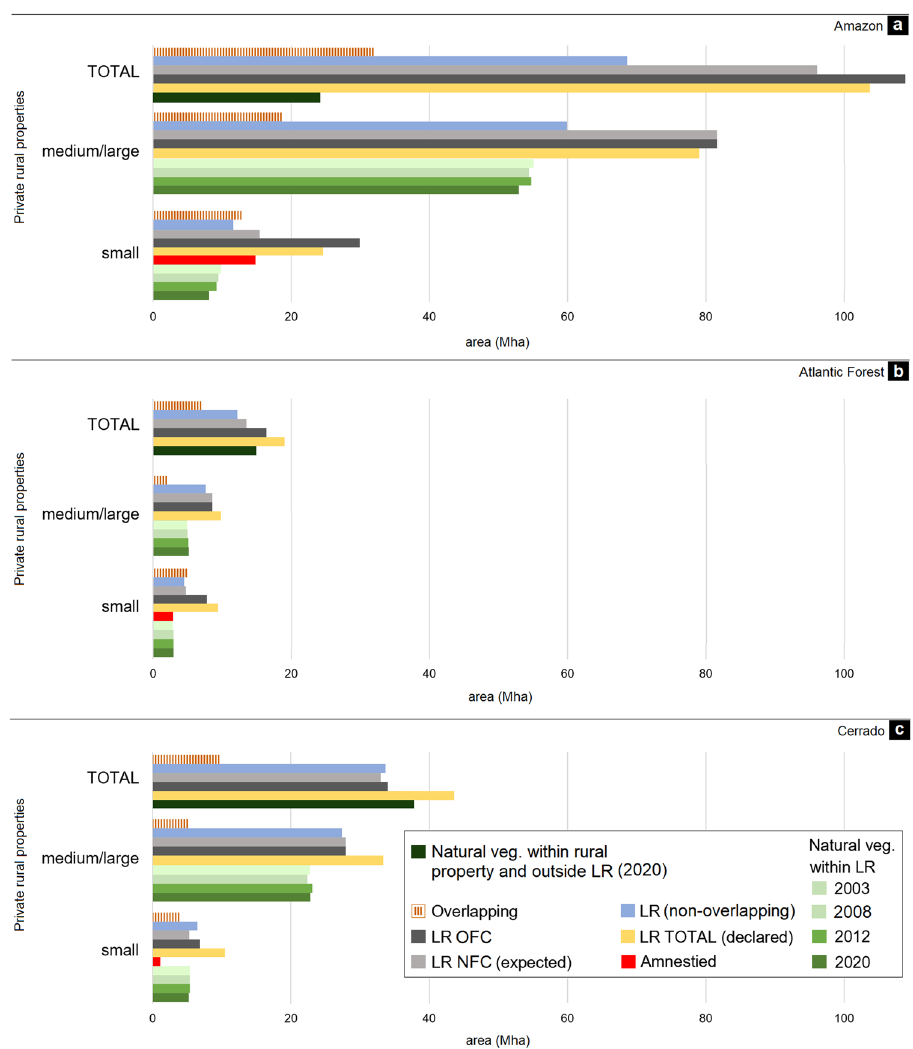
Fig. 2 Legal reserves (LR) within private rural properties and LR area according to the New Forest Code of 2012 and the old Forest Code of 1965. a Amazon biome; b Atlantic Forest biome; c Cerrado biome. The horizontal bars depict different situations with regards to the area required to be protected as LR between the old Forest Code (LR OFC) and in the New Forest Code of 2012 (LR NFC). Also depicted is the area declared by landowners (LR TOTAL), the overlapping areas among LR (Overlapping), the current area under LR within the rural properties without overlapping (LR), and the area released from the obligation to be recovered, i.e., expected by the old Code but spared in the new one (Amnestied). Natural vegetation cover is presented according to the rural properties ’ group size (i.e., small and medium/large), for 2003, 2012, and 2020. The data presented in Fig. 2 is provided in supplementary information (Supplementary Table 2). The calculations consider legal Articles 12 (without implementing potential fl exibilities for LR in Amazon) and 67 (which institutes the “ tolerant ” regime) of the NFC (see in “ Methods ”